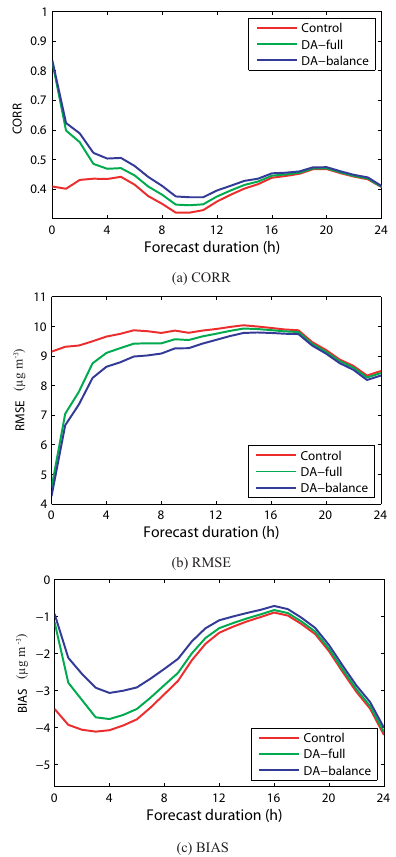
Figure 12. The averaged (a) correlations, (b) root mean square er- rors (RMSE in µgm − 3 ) and (c) mean bias (BIAS in µgm − 3 ) of the PM 2 . 5 concentration forecasts against observations as a function of forecast